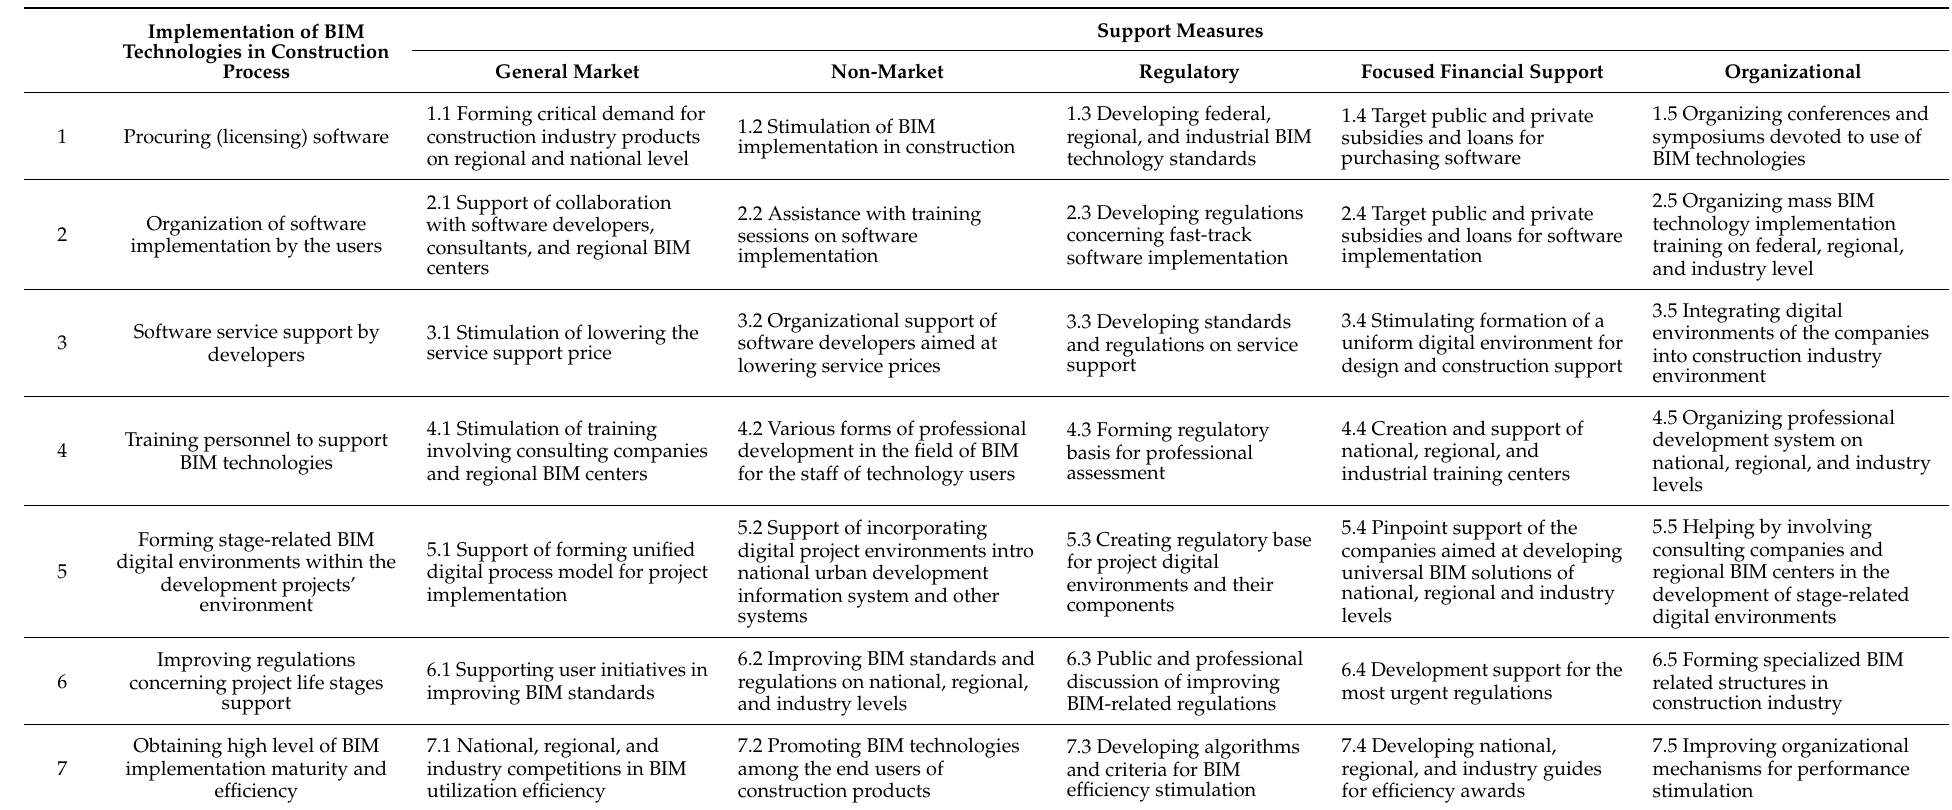
Table 2. Managing subprocesses of BIM software implementation in development project participants and public–private support measures for accelerated BIM implementation and